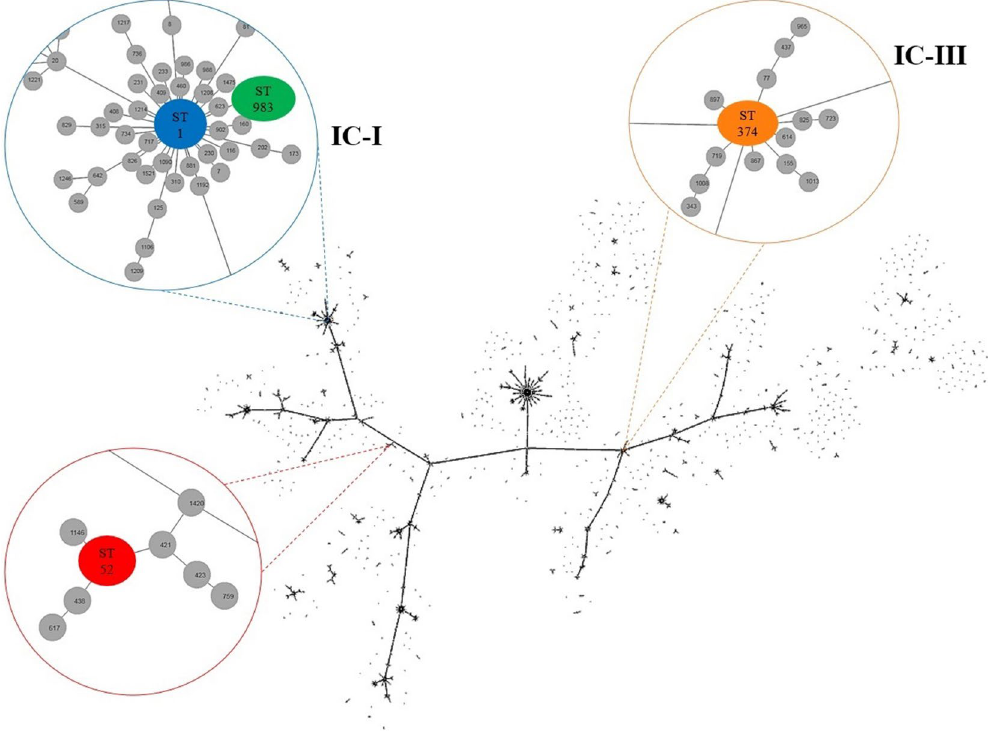
Figure 1. Diagram constructed by the goeBURST algorithm and using the Phyloviz software version 2.0 (http:// www. phylo viz. net/) indicating the similarity among sequence type (ST) and international clone (IC) corresponding to A. baumannii clinical isolates studied. Each line indicates that the connected circles correspond to STs sharing 6/7 of the alleles. The STs observed in the present study are enlarged and highlighted in color.